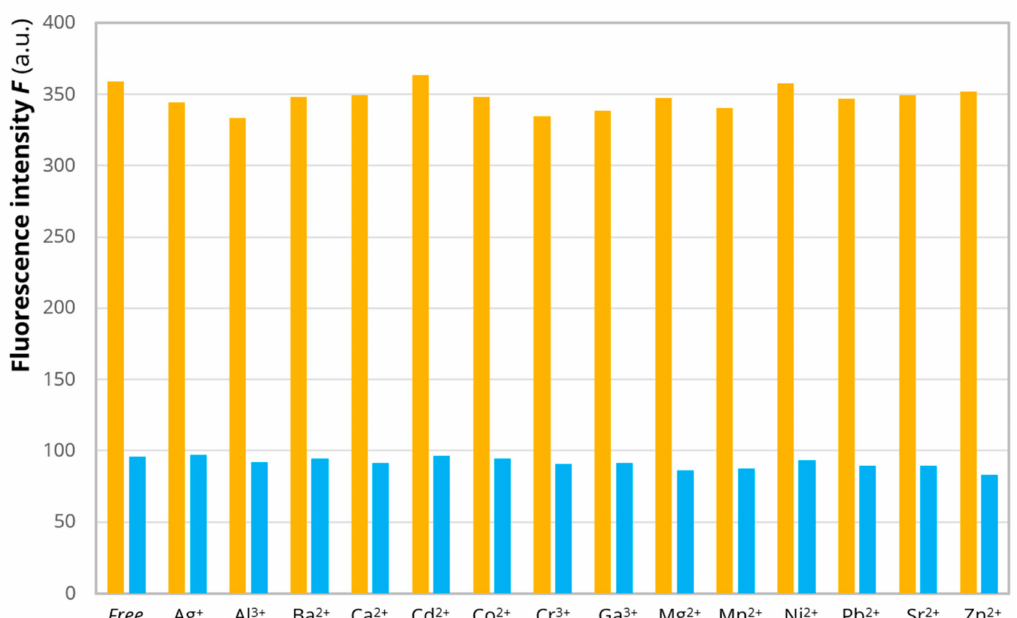
Figure 4. The fluorescence intensity (measured at 305 nm) of EHYHQ (0.1 mM) with the addition of 0.25 mM of various metal ions (orange columns) in 5 mM MES bu ff er (pH 6.0) and then with the addition of 0.05 mM of Cu 2 + ions (blue columns): Molar ratio 1:2.5:0.5 (EHYHQ to Me n + to Cu 2 +